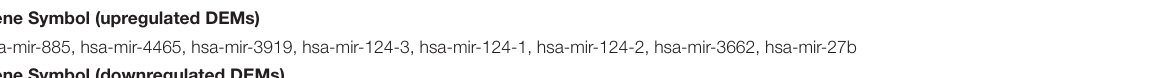
FIGURE 9 | Identification of early recurrence-associated DEMs in B-cell acute lymphoblastic leukemia from TARGET database. Volcano plot of DEGs from TARGET. Genes with p < 0.05 and | log2(FC)| > 0.5 are shown in red (upregulated microRNAs) and blue (downregulated microRNAs). TABLE 5 | The DEMs identified in 53 B-ALL patients from TARGET database. Gene Symbol (upregulated